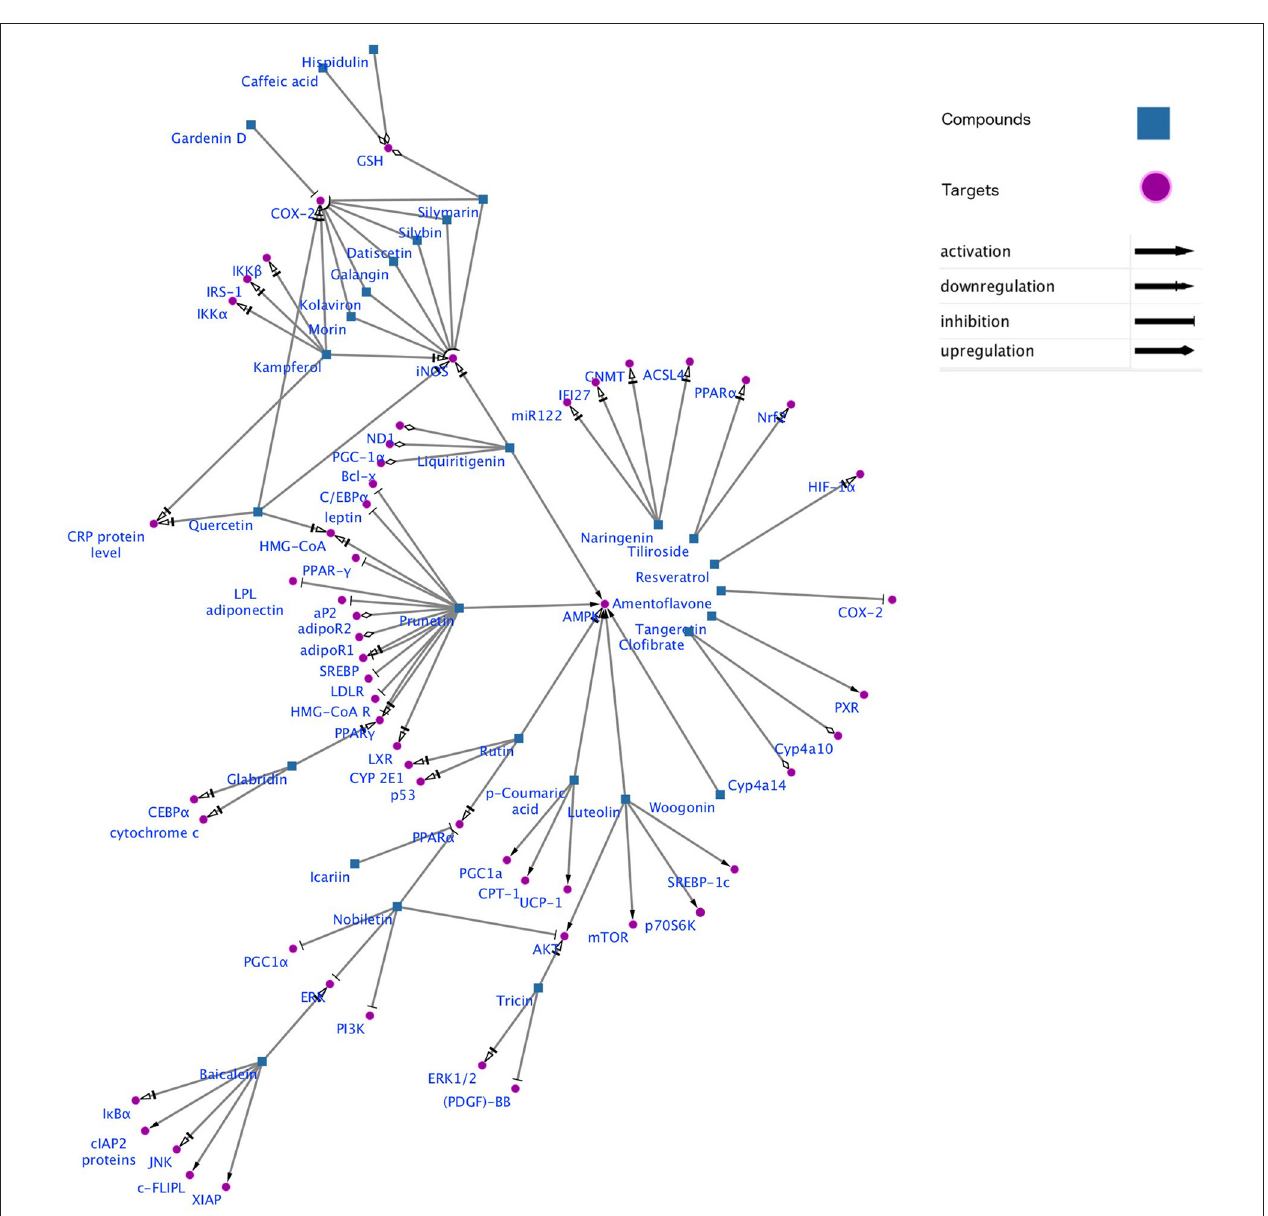
FIGURE 11 | Gene networking showing hepatotoxicity mediated gene expression and subsequent mode of action of various natural products. This network was generated by a software Cytoscape version 3.6.1.